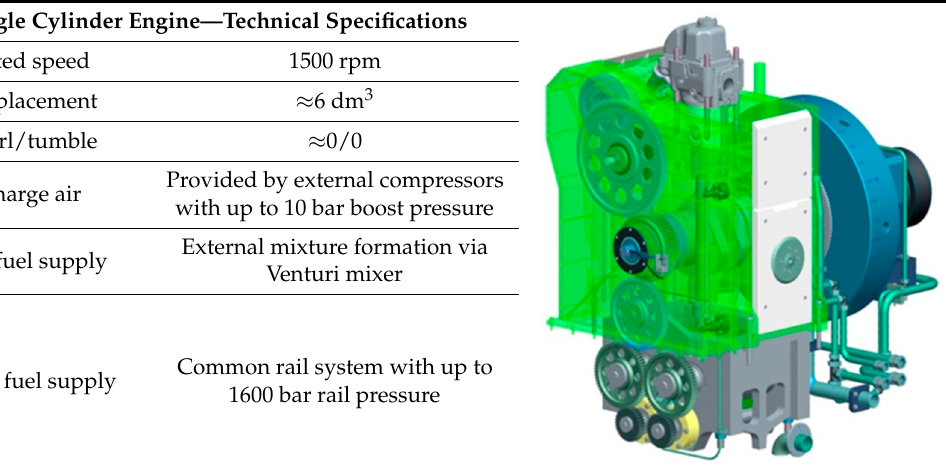
Table 3. Technical specifications of the SCE and CAD mockup of the engine.